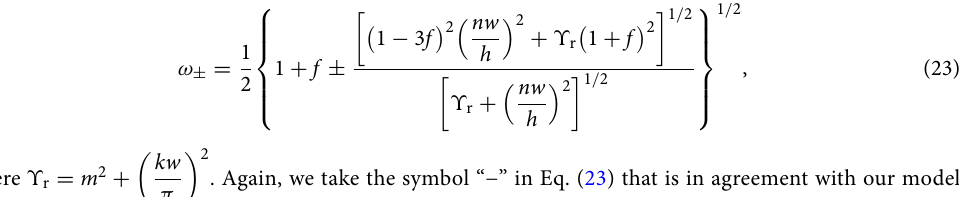
1, 2, 3 , and m 1, 2, 3 . ( a ) A rectangular = = 2 a w ), using Eq. = =